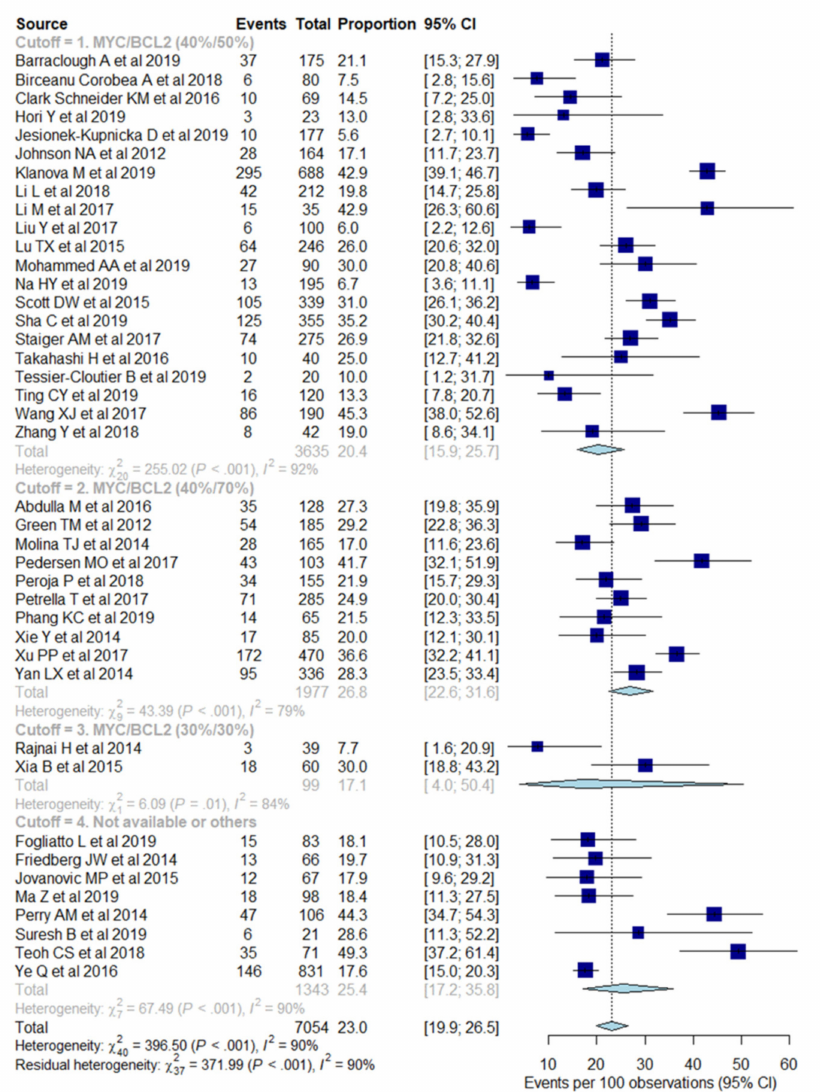
Figure 2. Forest plots show pooled proportion of double protein expression of MYC and BCL2, stratified to different cutoff values by immunohistochemical staining. The events represent double expressor status. The blue box represents the point estimate and its area represents the weight given to the study and a horizontal line indicates the 95% confidence interval. The diamond represents the combined results and the length of the diamond indicates the confidence interval of the pooled results. At the bottom of the plot, the overall pooled proportion is represented by the dashed vertical line and the